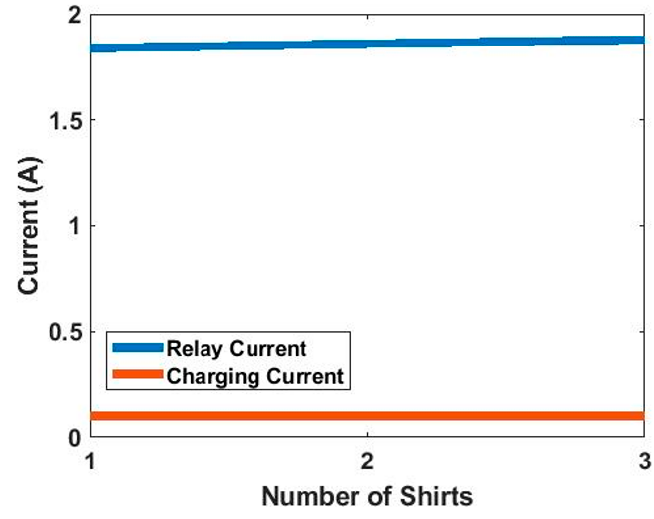
Figure 26. Measured charging current and relay coil current with different numbers of